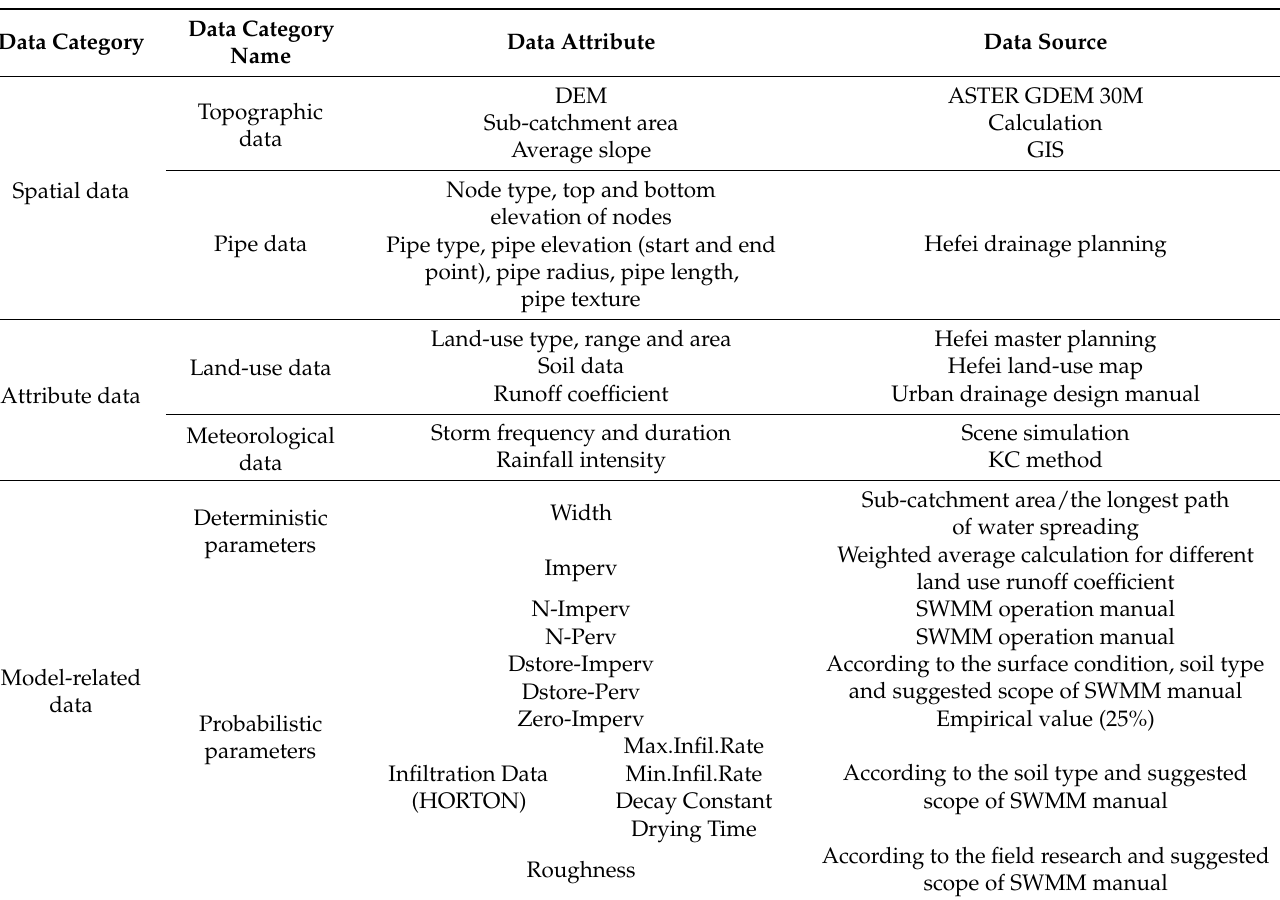
Table 1. SWMM parameter